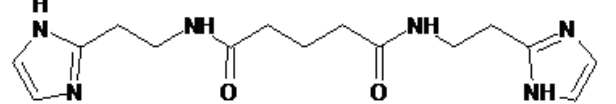
Figure 8. Structural formula of pharmacological compound Bisamide Derivative of Dicarboxylic